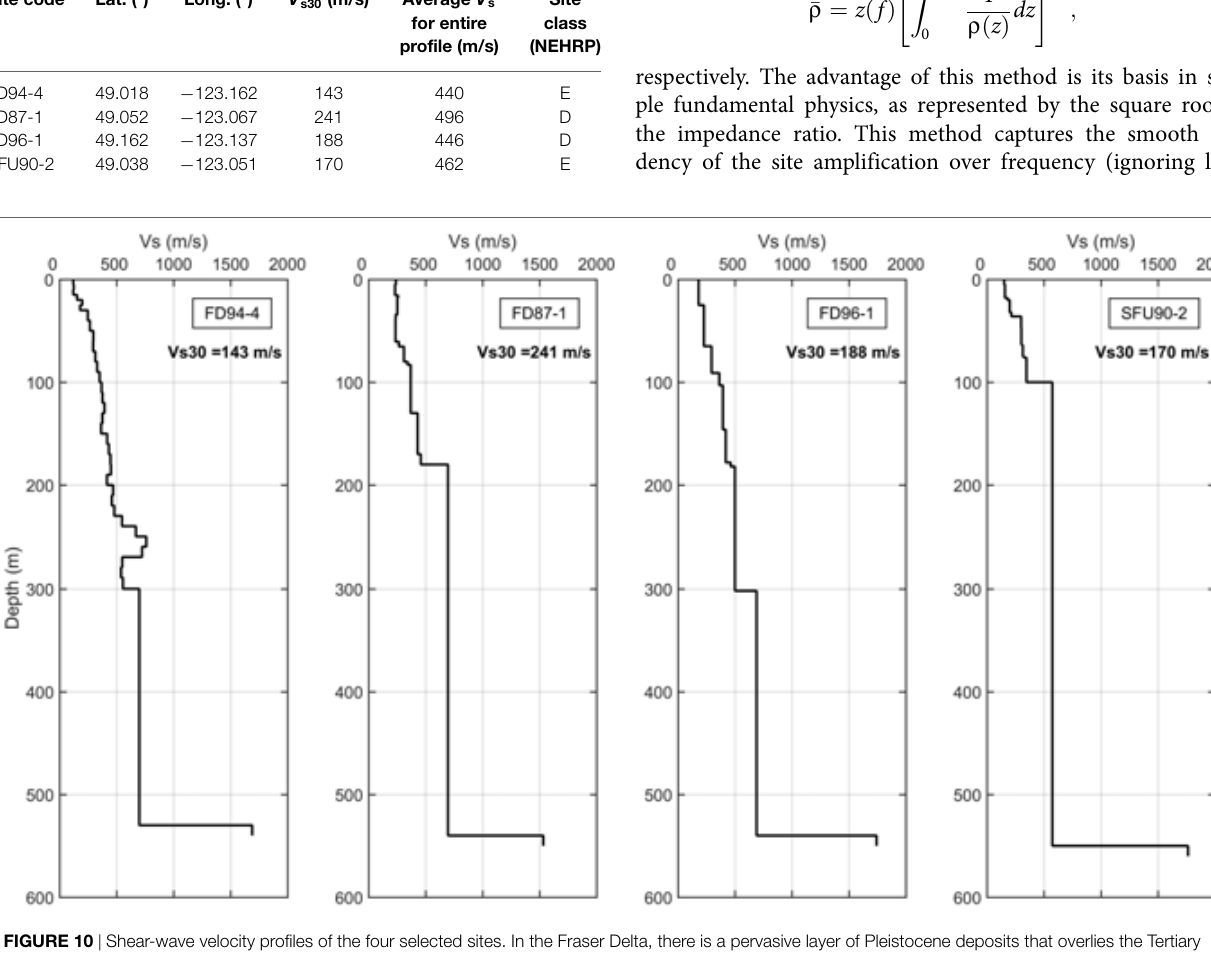
FIGURE 10 | Shear-wave velocity profiles of the four selected sites. In the Fraser Delta, there is a pervasive layer of Pleistocene deposits that overlies the Tertiary bedrock; the Pleistocene layer has a stable V s gradient from 400 to 1,000m/s, while the Tertiary bedrock has an average V s of 1,500m/s (Hunter, 1995; Hunter et al.,